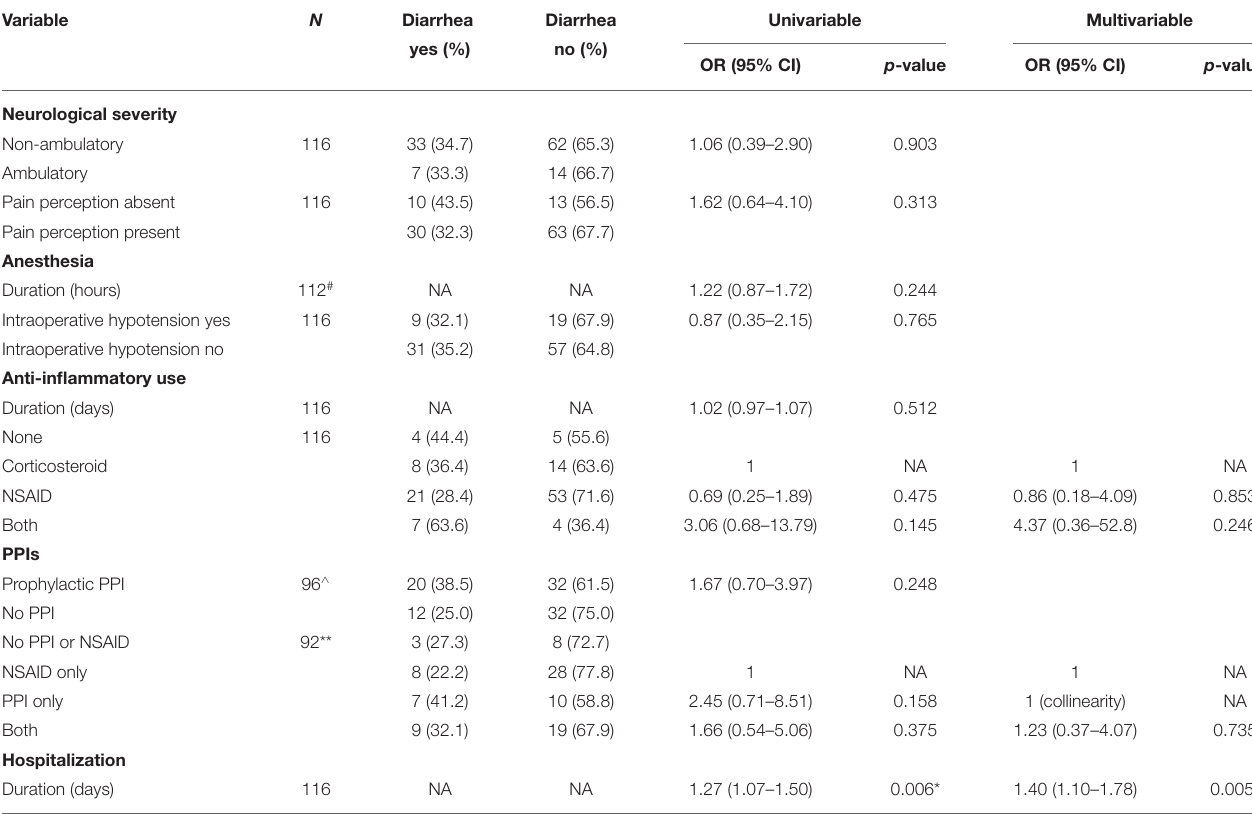
TABLE 6 | Univariable and multivariable analysis of risk factors for the development of diarrhea in 116 dogs undergoing surgery for TL-IVDE. Variable N Diarrhea Diarrhea Univariable Multivariable yes (%) no (%) OR (95% CI) p -value OR (95% CI) p